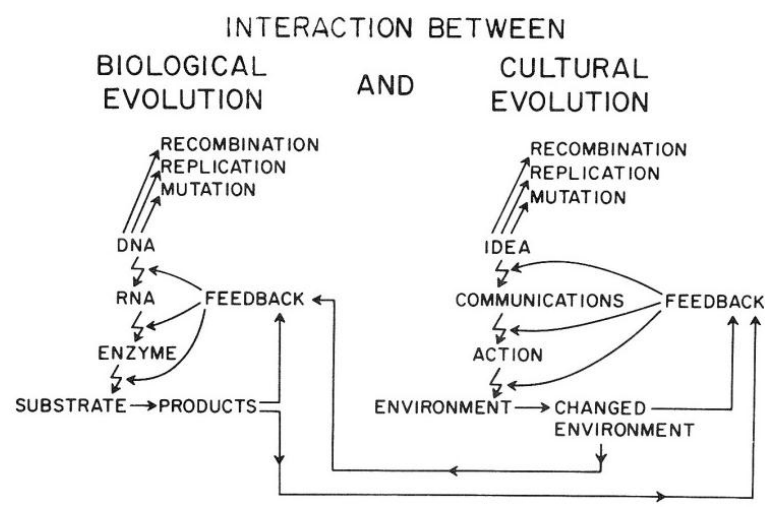
Figure 14. Feedback between processes of biological and cultural evolution (Modified from Figure 8, p. 107, in Potter’s Bioethics: Bridge to the Future; Prentice-Hall; New York; 1971. [141]).